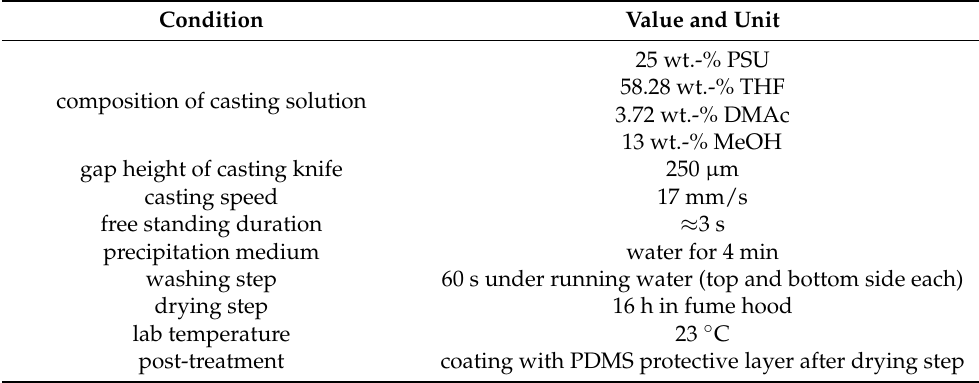
Table 2. Optimized fabrication conditions for PSU flat sheet